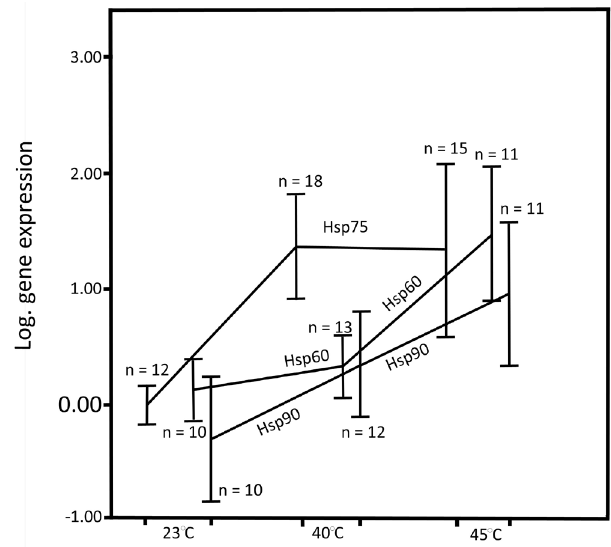
Fig 2 . Laboratory experiment – expression of Hsp60, Hsp75 and Hsp90 in F . cinerea workers in 40ºC and 45ºC thermal chambers comparing to control (23ºC). Mean log. value of gene expression and 95% confidence interval (Cl) error